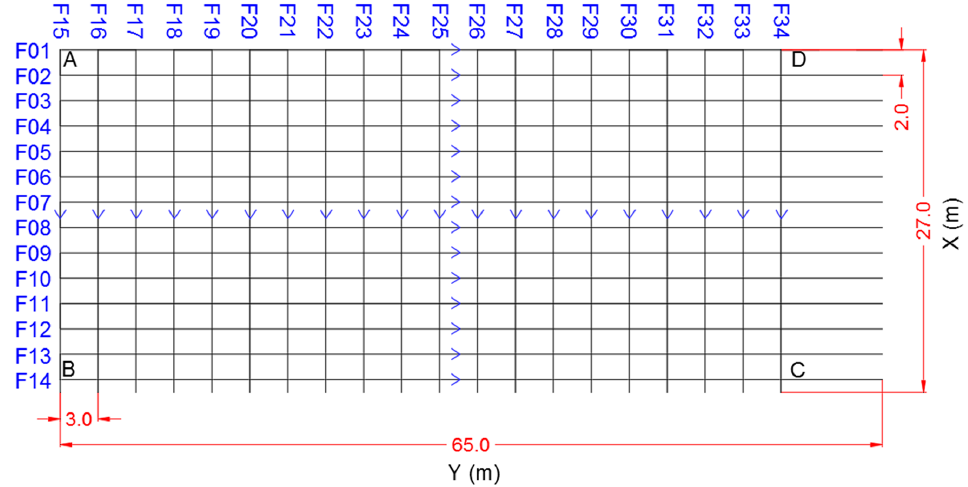
Figure 4. The Ground Penetrating Radar (GPR) survey design. The blue arrows refer to the direction of the survey lines.